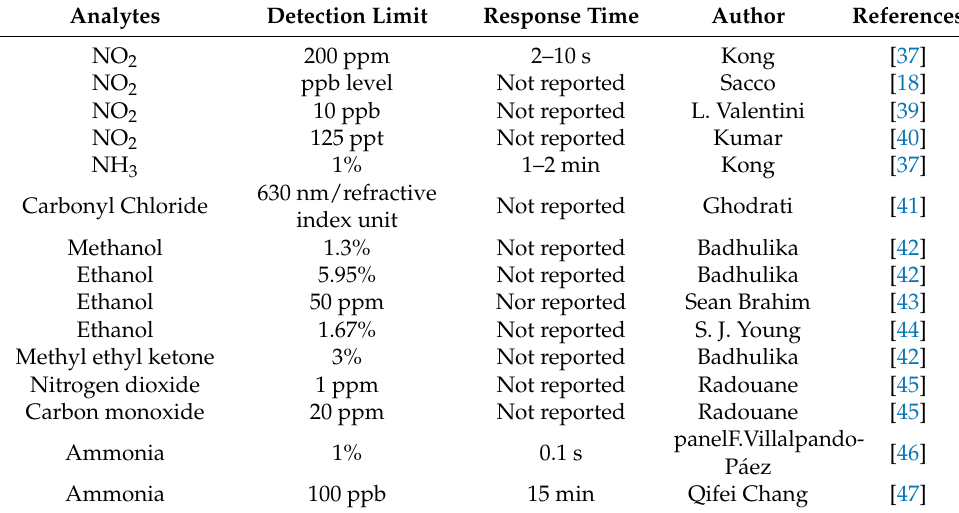
Table 1. The research on CNTFET for gas